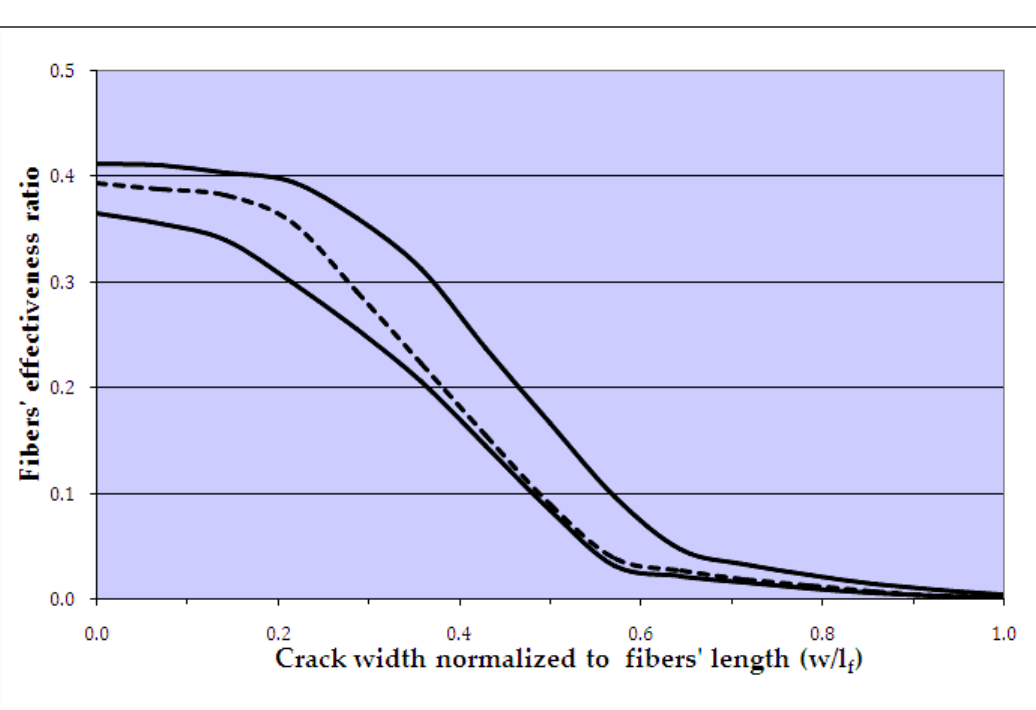
Figure 10. The effectiveness ratio of the fiber in relevance with crack width for several steel hooked fibers. (Continuous lines for upper and lower bounds, dotted line for the case study presented in detail).